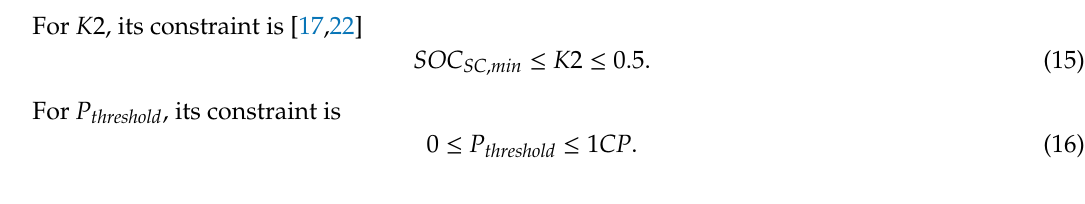
Algorithm 1 Code structure of searching the parameter set.